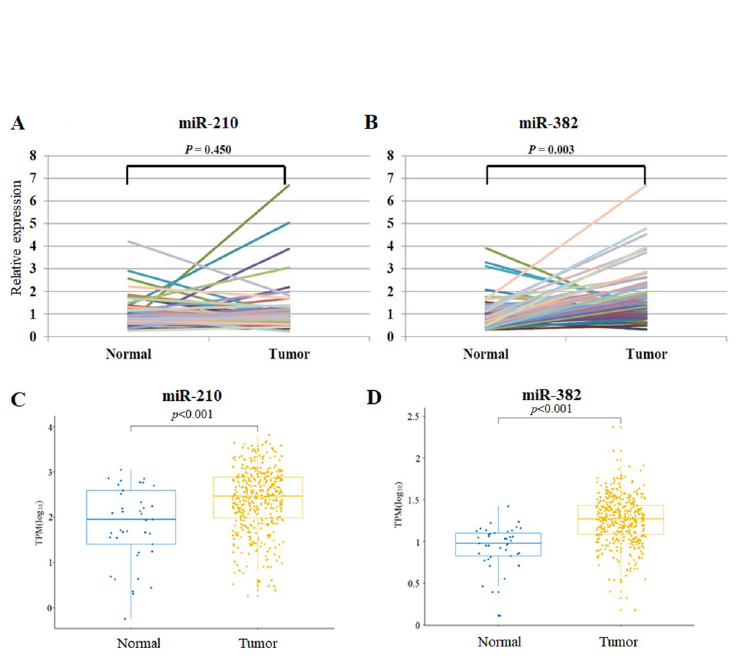
Fig 3. Predictive values of miR-210 and miR-382 expression in gastric adenocarcinoma in comparison with normal tissues. (A-B) The levels of miR-210 and miR-382 were measured by quantitative PCR after reverse transcription. miR-382 expression was significantly higher in tumor than that in paired normal tissues ( p < 0.001), while miR-210 expression did not differ between two groups ( p = 0.472). (C-D) GDC data set analysis of miR-210 and miR-382 expression was performed. 446 GCs (STAD) and 45 normal tissue was analyzed using the GDC data set. P value is calculated by using Student t test.